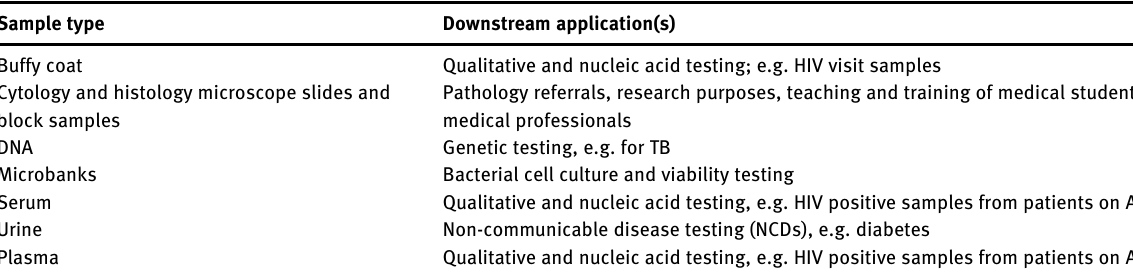
Table  : Sample pro fi les and downstream